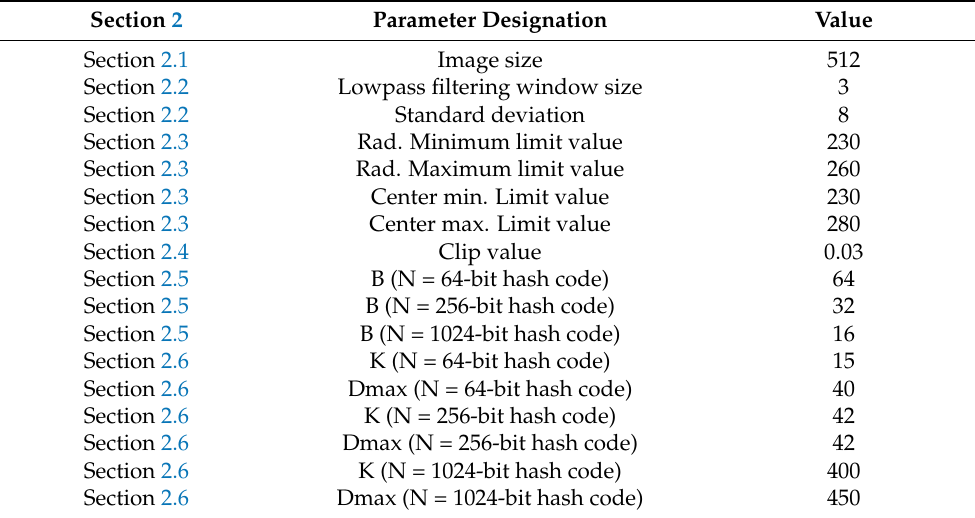
Table 1. List of parameter